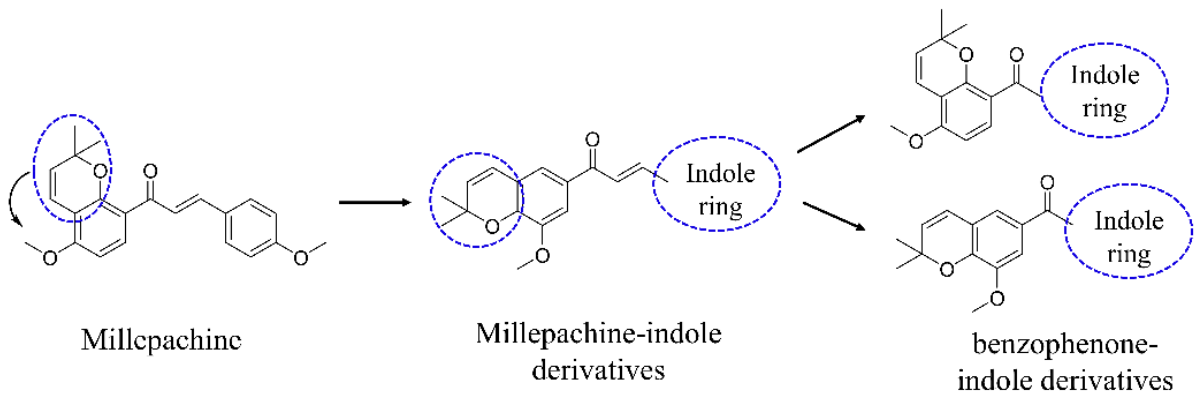
Figure 1. The design strategy for indole-containing hybrids derived from millepachine.